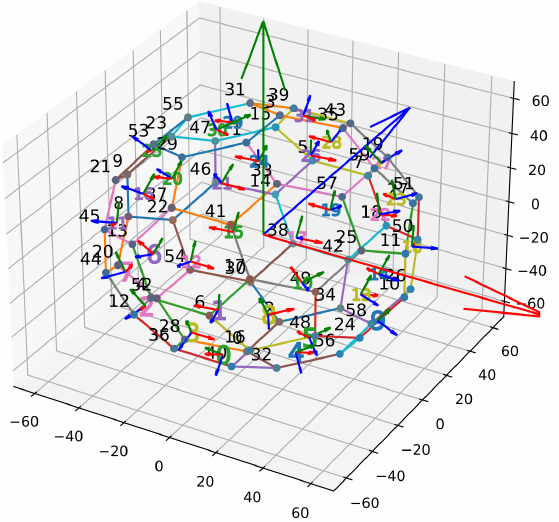
Figure 2. The truncated Icosahedron design with the relative transformations between the polygon center’s coordinate system (c.s.) and each marker’s